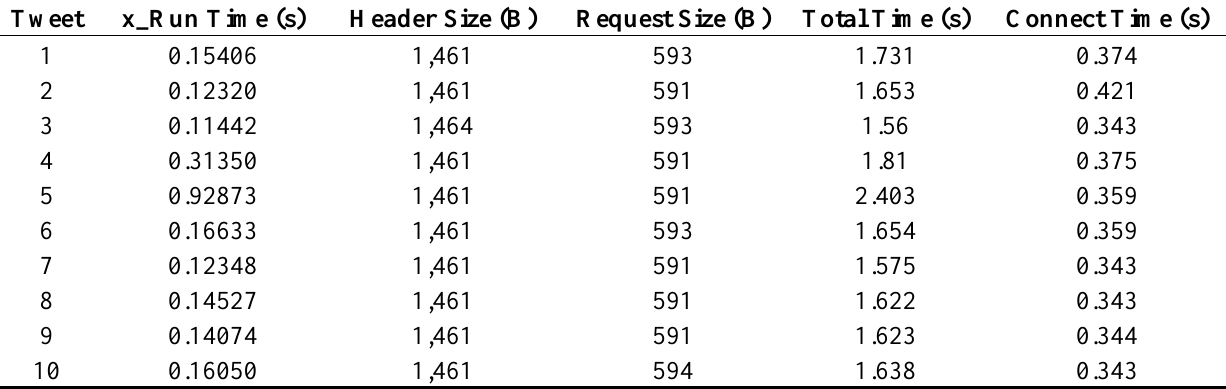
Table 8. Some measurements obtained for different